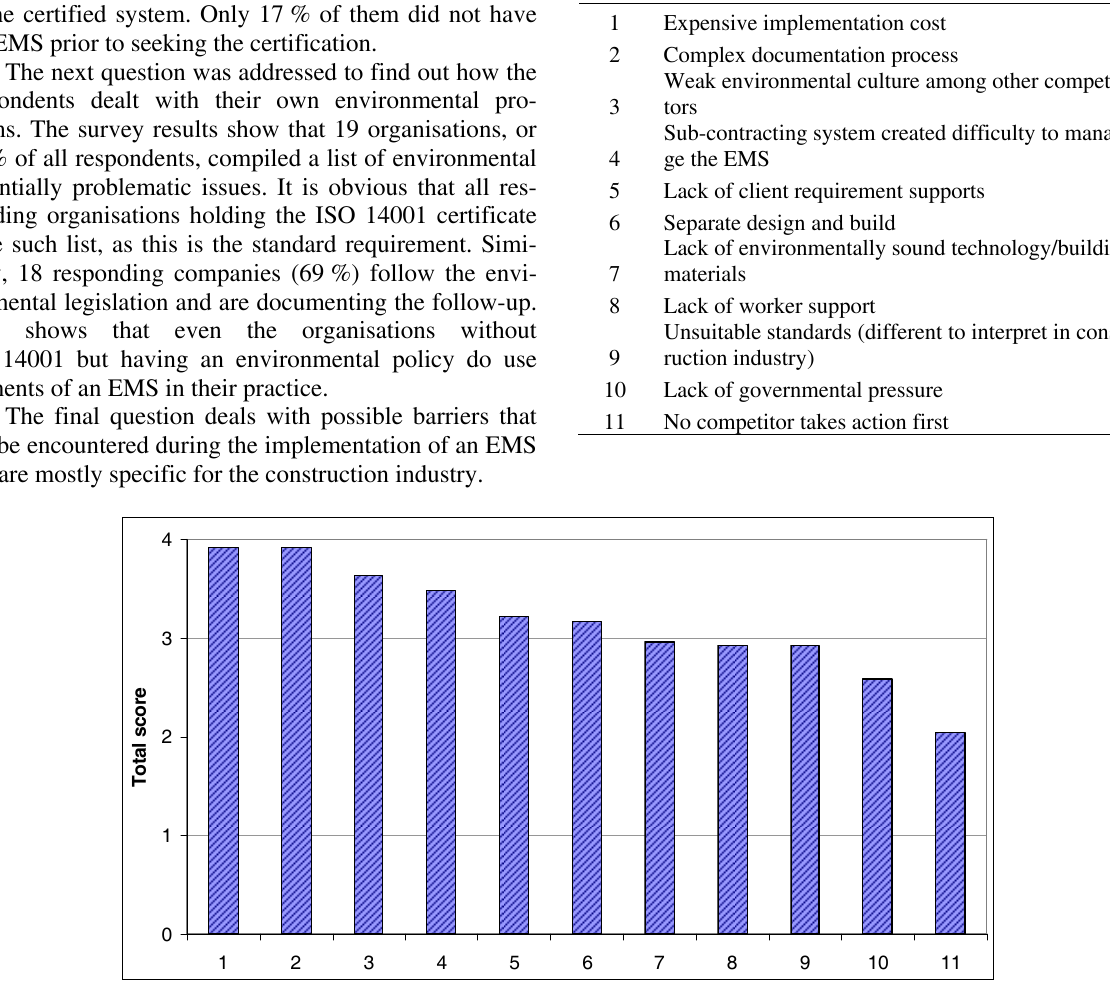
Fig 3. Importance of barriers to implementation of ISO 14001 as perceived by the respondents: 1 – expensive implementation cost , 2 – complex documentation process, 3 – weak environmental culture among other competitors, 4 – sub-contracting sys- tem created difficulty to manage the EMS, 5 – lack of client requirement supports , 6 – separate design and build, 7 – lack of environmentally sound technology/building materials, 8 – lack of worker support , 9 – unsuitable standards (different to interp- ret in construction industry), 10 – lack of governmental pressure, 11 – no competitor takes action